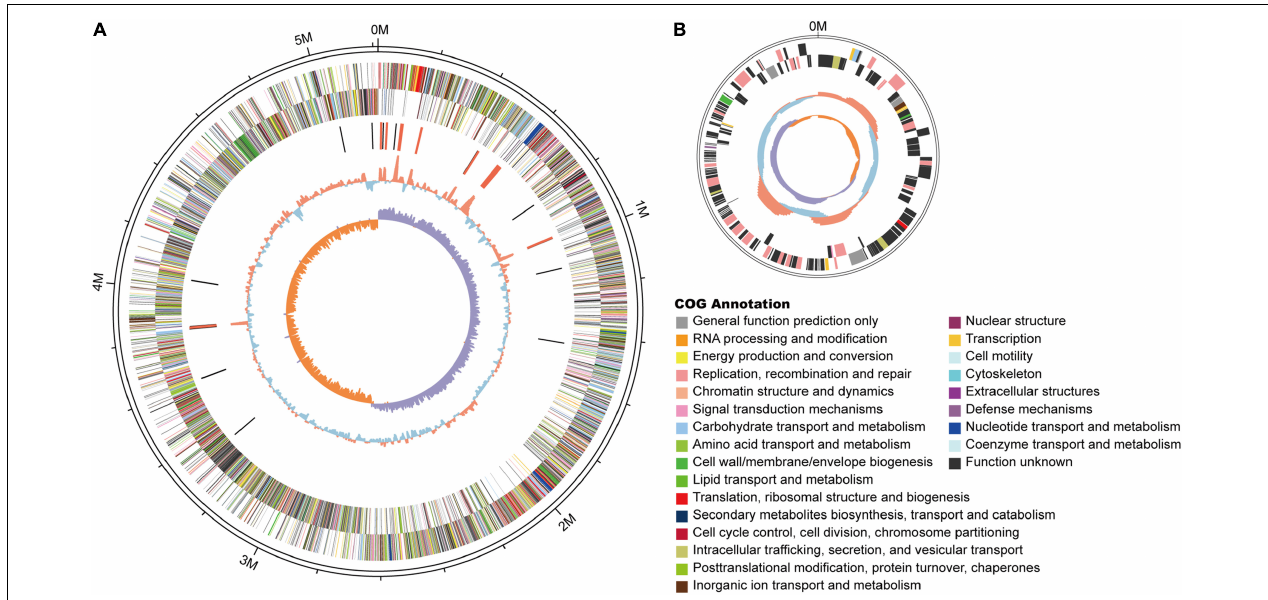
FIGURE 5 | Schematic of the complete GN03 genome. GN03 chromosome (A) and plasmid (B) . Rings represent the following features labeled from the outside to the center, where the outermost circle represents the scale in bp: the first ring represents positive strand genes and the second ring represents negative strand genes. Each color patch represents a COG functional classification. The third ring represents ncRNA (black indicates tRNA, red indicates rRNA). The fourth ring represents the GC content (red indicates GC content above the mean, blue indicates GC content below the mean). The innermost ring shows the GC skew (GC skew = [GC]/[G + C]; purple means greater than 0, orange means less than 0). Circos v0.62 (http://circos.ca/) software was used to draw the genomic circle map.